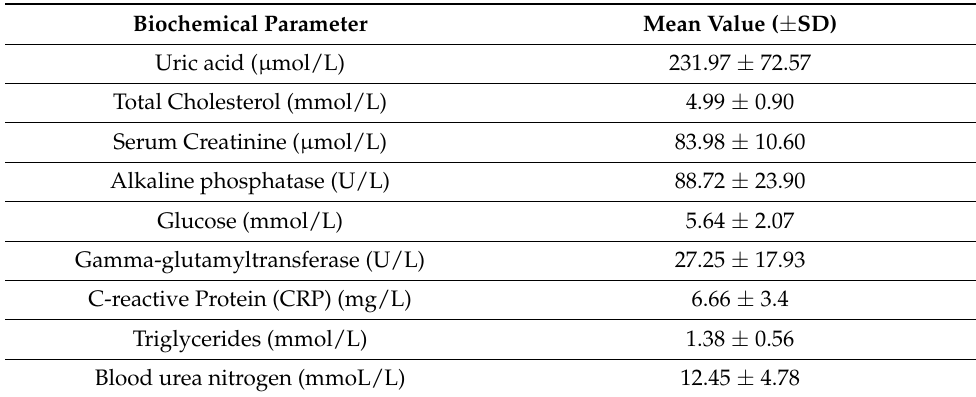
Table 3. Mean values of the blood biochemical parameters.